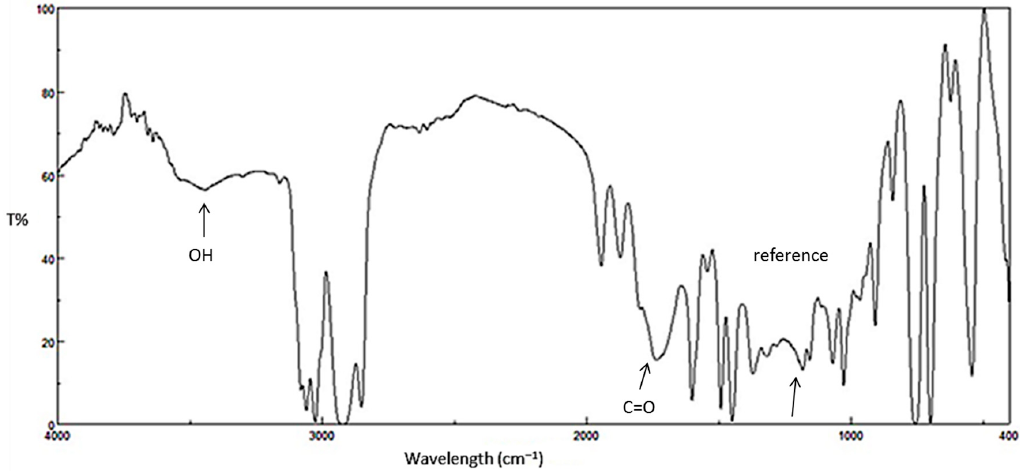
Figure 3. FTIR spectrum for PS film after irradiation (250 h).